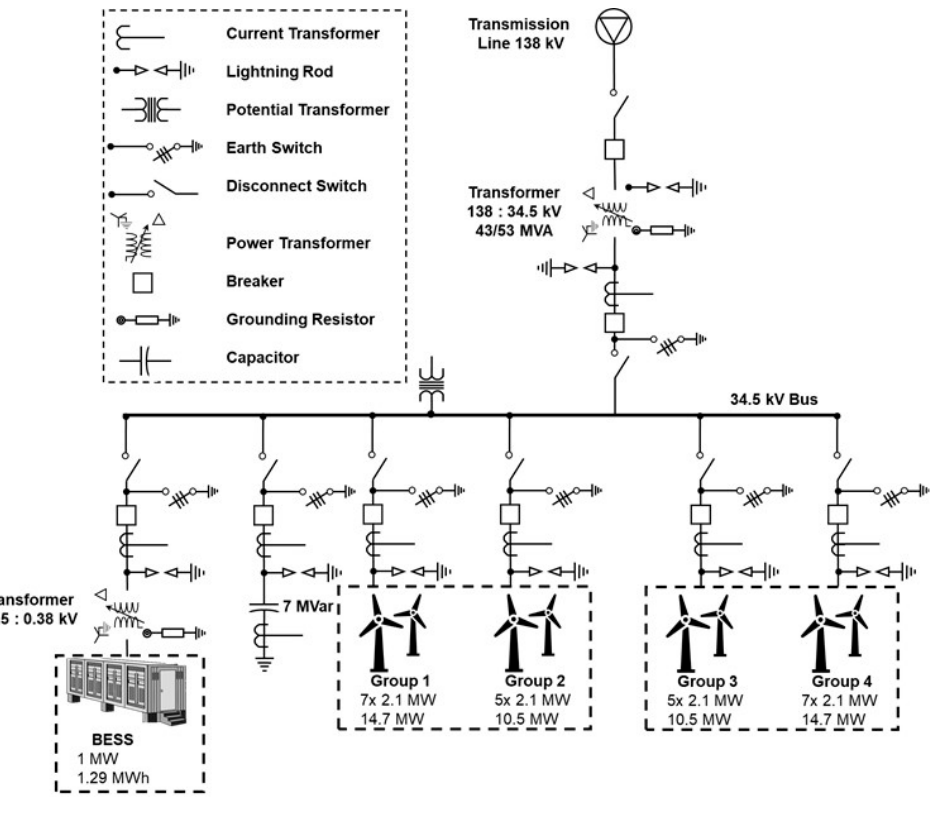
Figure 6. CDV single-line diagram. Reprinted from [ 20 ] with permission (Licensee MDPI, Basel, Switzerland).